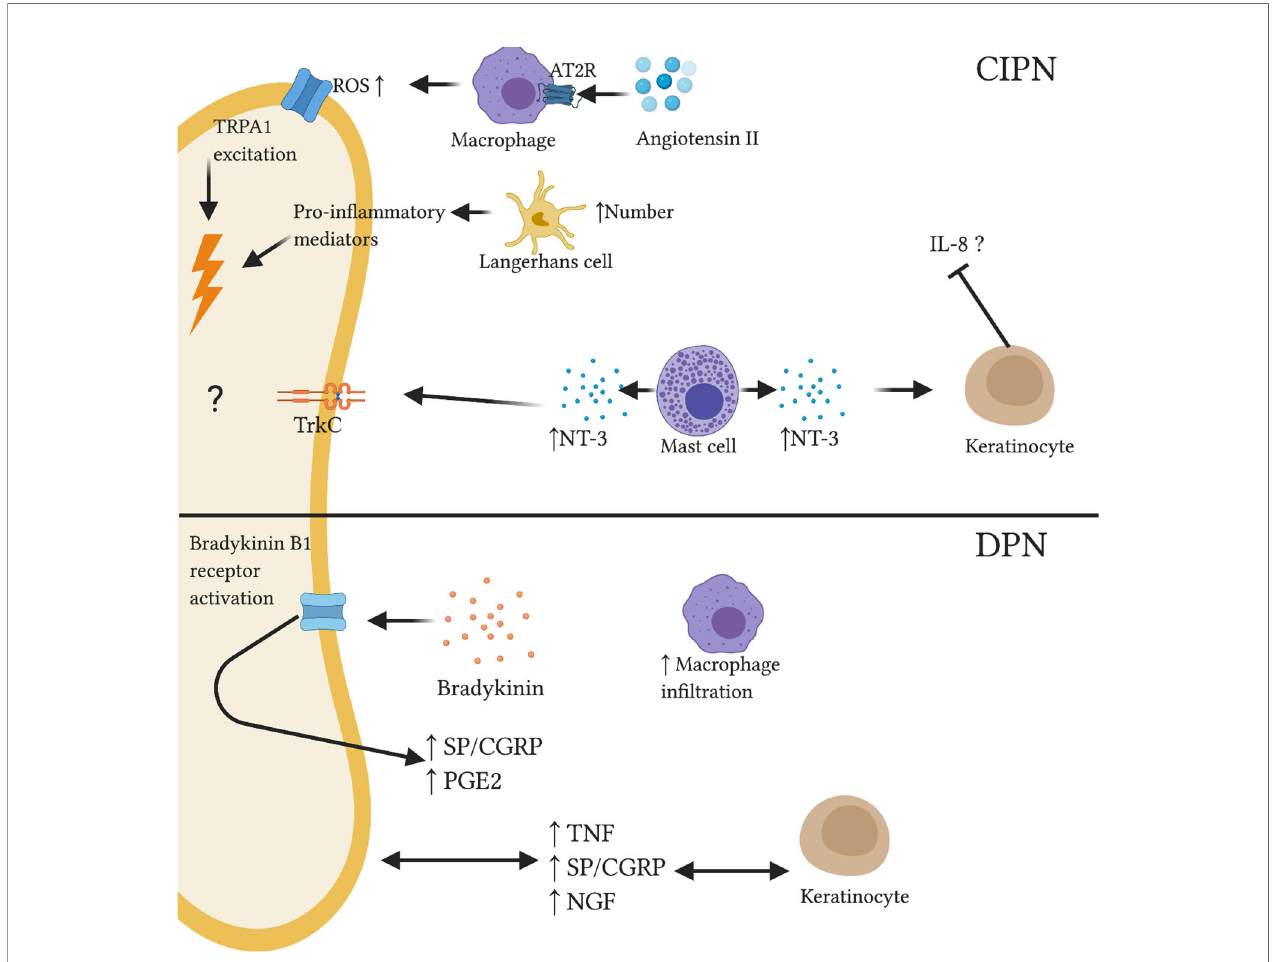
FIGURE 3 | Reported and speculative neuroimmune interactions within the skin in CIPN and DPN. In a CIPN mouse model, Angiotensin II administration resulted in macrophage release of reactive oxygen species via AT2R. TRPA1 stimulation caused nociceptor excitation. Increased number of activated Langerhans cells may release pro-in fl ammatory mediators which can sensitize nociceptors. Altered expression of neurotrophins such as NT-3 may affect immune and neuronal function; elevated levels of mast cell-derived NT-3 associated with reduced IL-8 production from keratinocytes in skin of AD patients. In DPN, abnormal neurotrophin signalling may disrupt keratinocyte and neuronal function. Bradykinin administration was shown to upregulate in fl ammatory neuropeptides SP and CGRP and in fl ammatory lipid PGE2. Further, increased macrophage in fi ltration was observed in the skin of diabetic